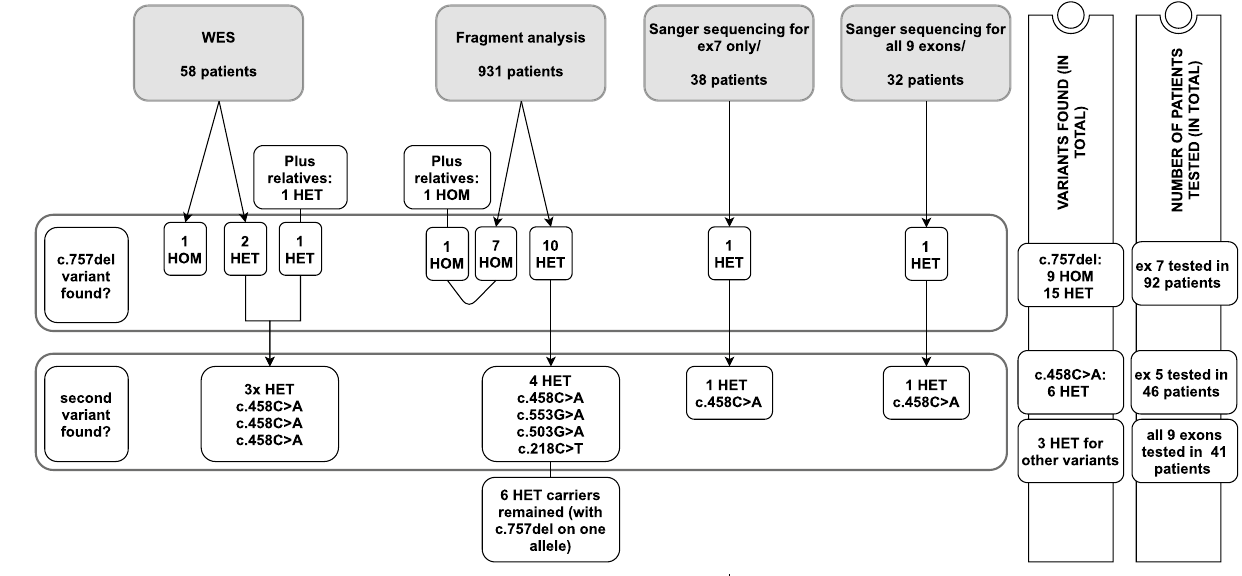
Figure 1. Workflow of the study. Four different analyses were done. In total, biallelic SORD variants were identified in 18 patients from 16 unrelated families. Prevalent variant is the